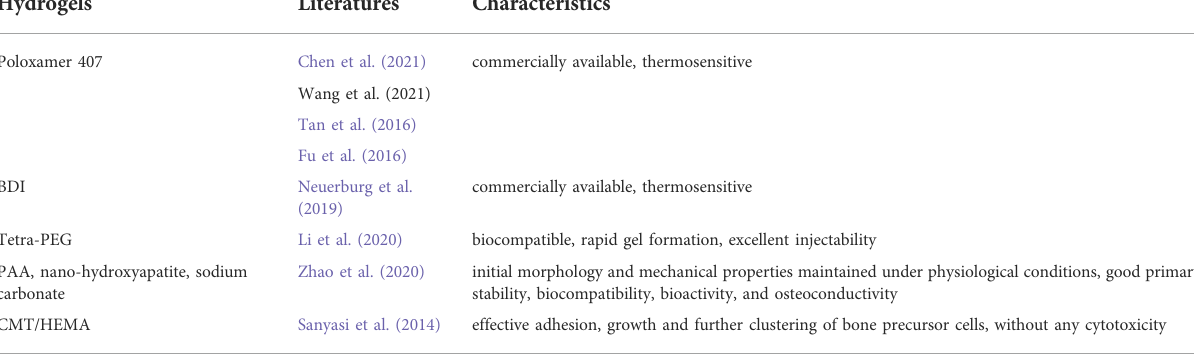
TABLE 2 Components and characteristics of synthetic